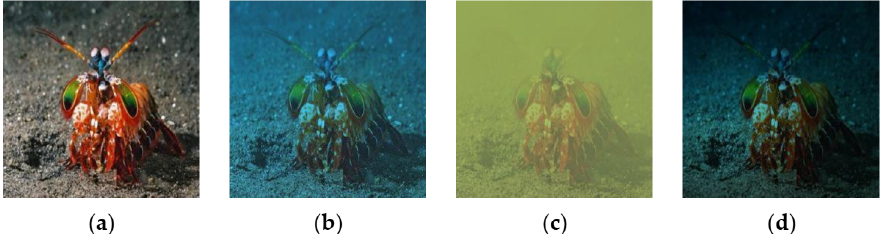
Figure 10. Sample images used for comparing the UIQM metrics and the three metrics used in this study. These images are taken from Figure 5, where ( a ) is the high-quality image and ( b – d ) are simulated underwater images with various degradation problems. Corresponding evaluation results are presented in Table 6. Table 6. Comparison of UIQM metrics and the three metrics used in this study on images from Figure 10. ↓ means smaller scores are better. ↑ means larger scores are